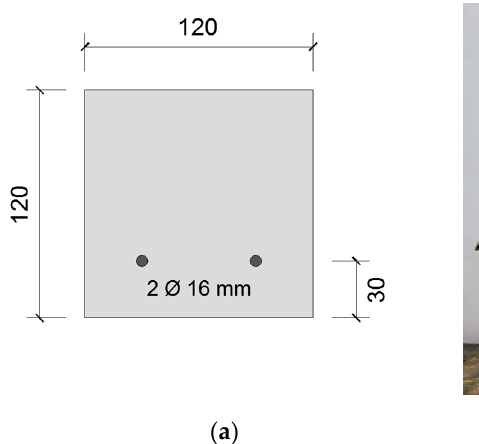
Figure 7. Cross-section of water permeability specimen (dimensions in mm).